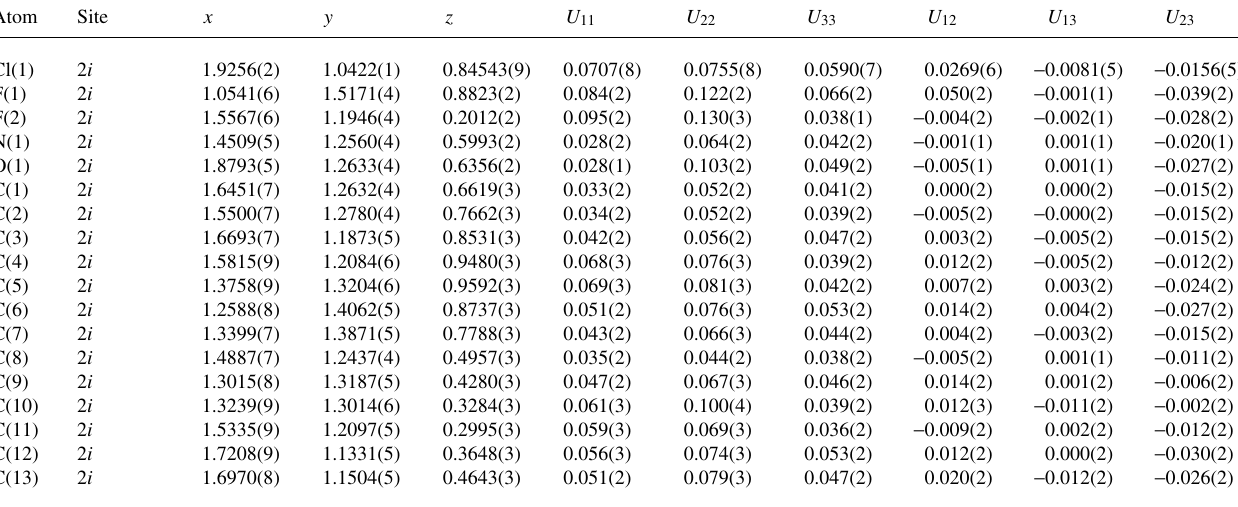
Table 3. Atomic coordinates and displacement parameters (in Å 2 ) .